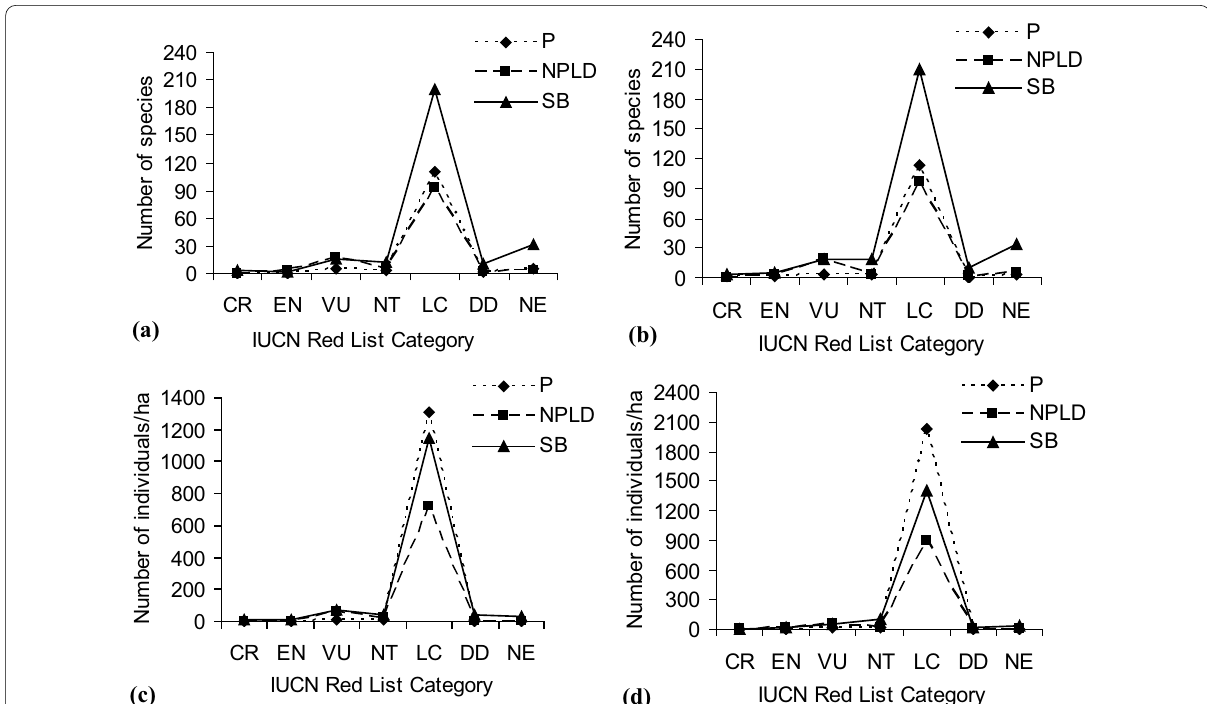
Fig. 3 Distribution of pioneer, non‑pioneer light demanding, shade‑bearer species and densities in different IUCN Red List categories in the rural forests of Essiengbot‑Mbankoho ( a, c ) and Nbgwassa‑Opkweng ( b, d ). P pioneer, NPLD non‑pioneer light demanding, SB shade‑bearer. CR Critically Endangered, EN Endangered, VU Vulnerable, NT Near Threatened, LC Least Concern, DD Data Deficient, NE Not